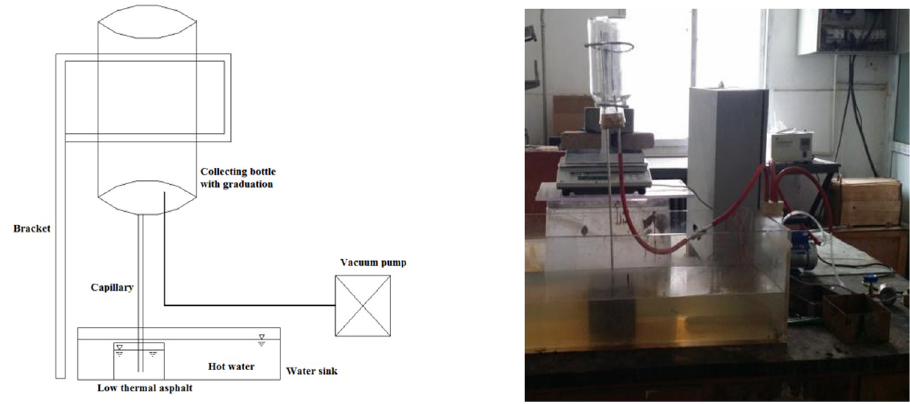
Figure 4: Vacuum decompression capillary device to measure viscosity.